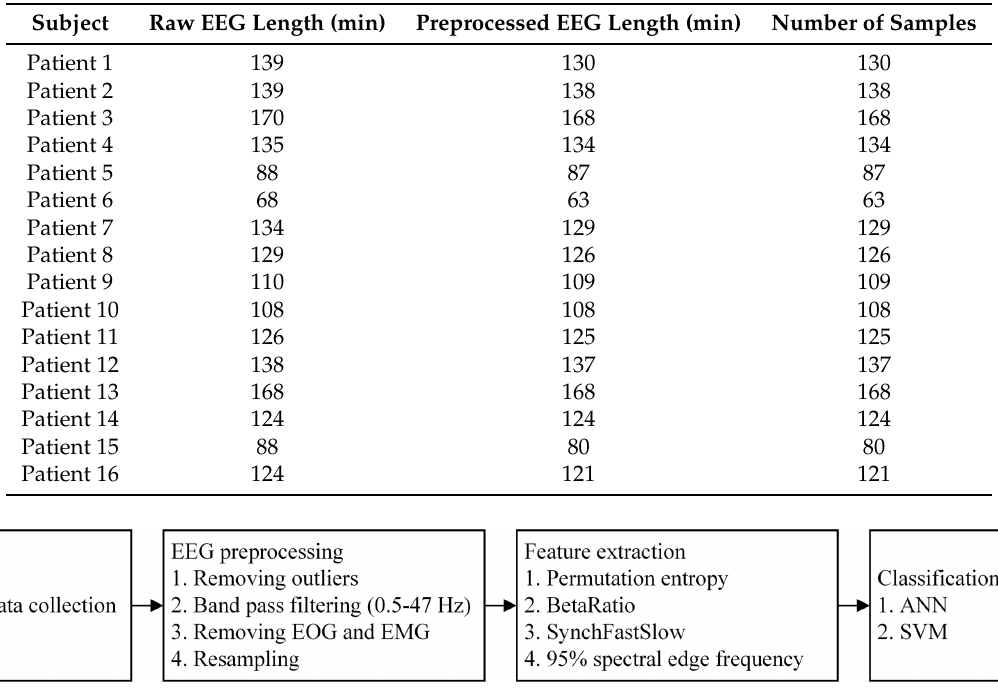
Table 1. The information of the EEG data.